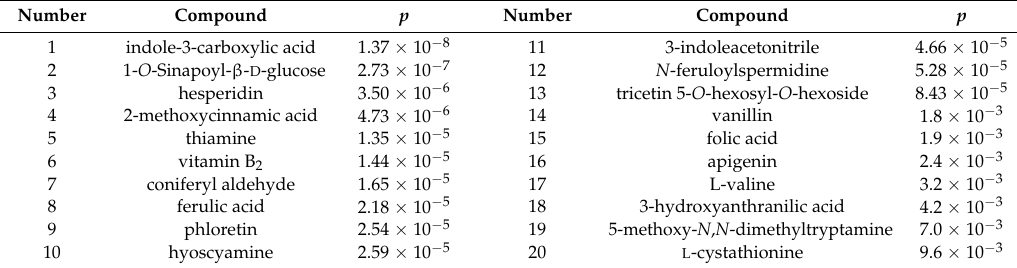
Table 2. Significant differences of 20 metabolites in black and white sesame seeds. According to Volcano plot, if p -value is less than 0.01 and the fold change is greater than twice or less than half, significant difference of the metabolite exists between black sesame and white